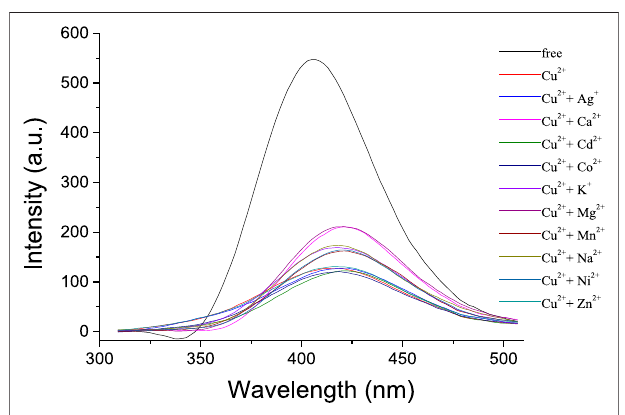
FIGURE 4 | Fluorescence spectra ( λ exc (cid:1) 334 nm, Slit (cid:1) 2.5) of 1 (1 × 10 − 6 mol/L)and Cu 2+ (10 equiv)upon addition ofothermetalions (10equiv) in CH 2 Cl 2 /CH 3 CN (1,000:1, v/v).